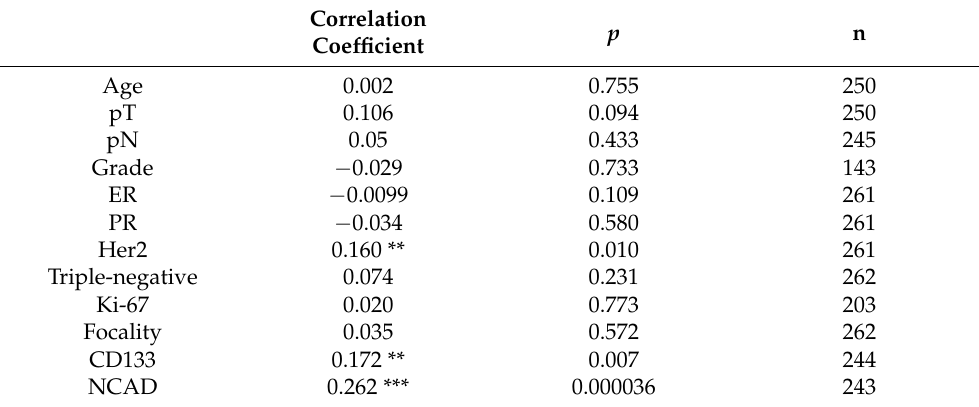
Table 2. Correlations of double cytoplasmic staining (RXR α positive/PPAR γ high) with clinical parameters in the whole cohort of 250 BC patients.